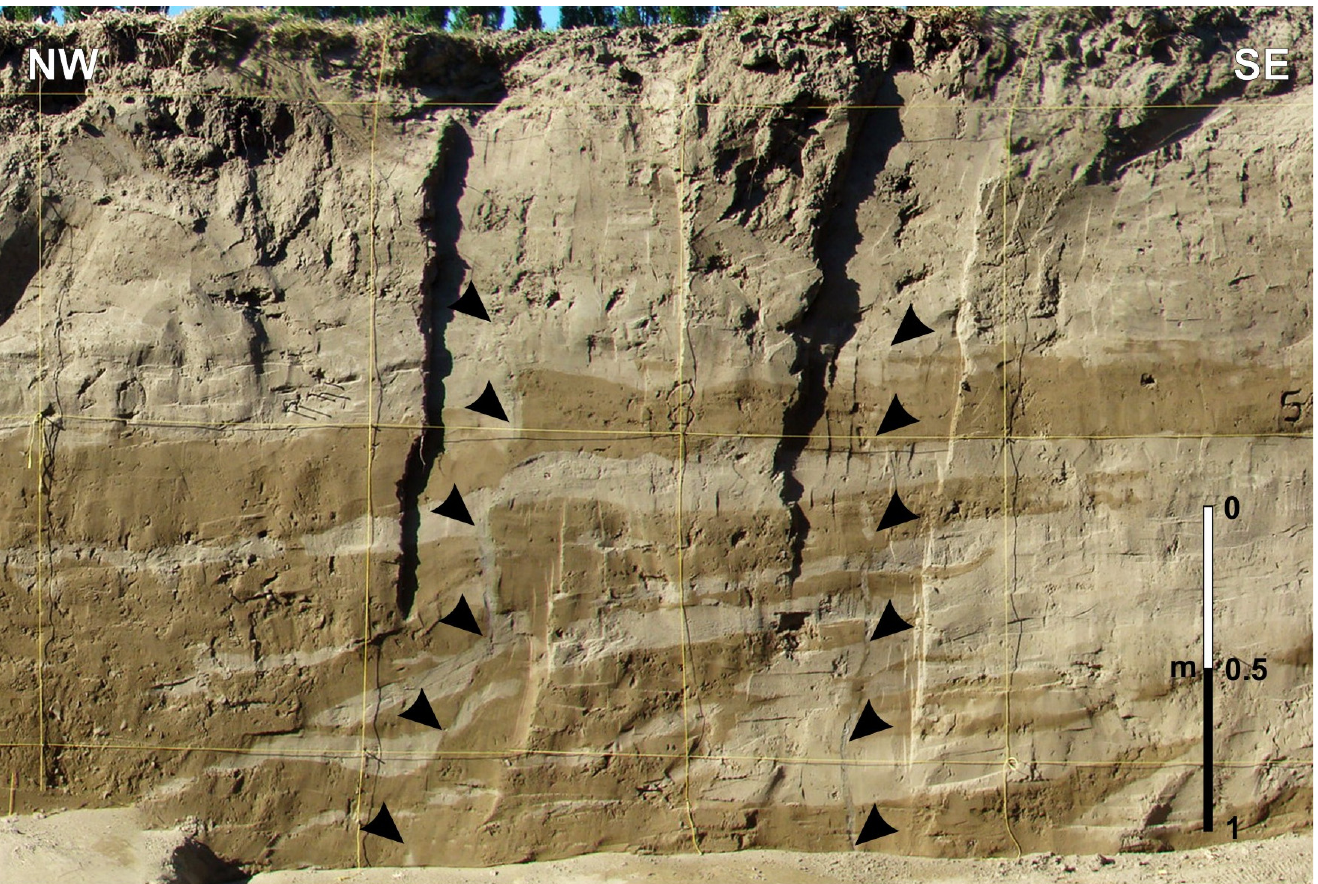
Figure 5. Example of sand-filled dikes (D6 and D7 in the northeastern wall) that affected the levee-associated deposits and interrupted below the ploughed layer. See Figure 3 for location in the trench